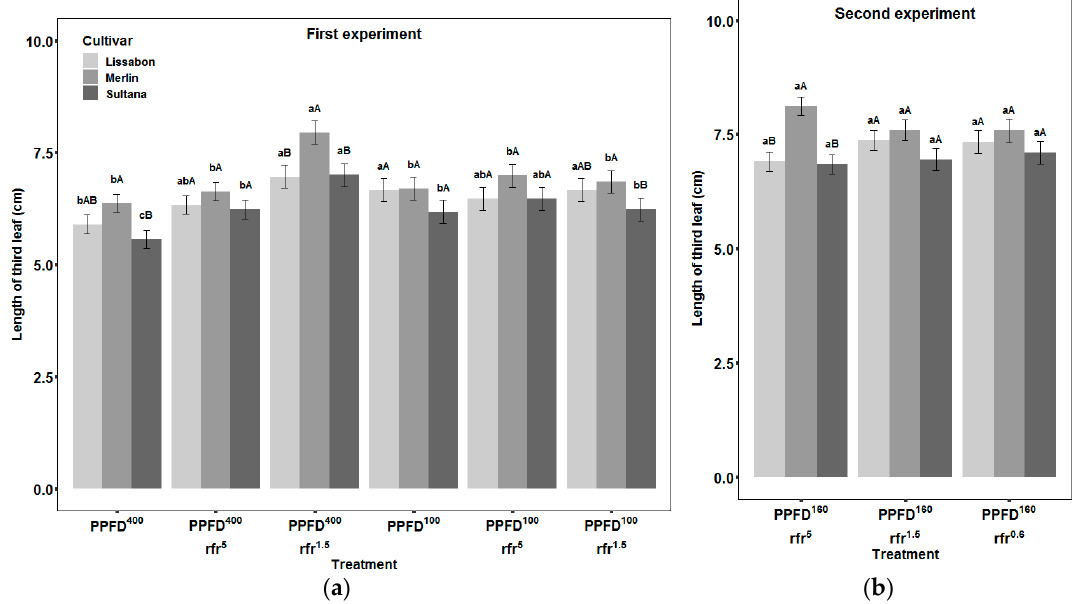
Figure 5. The least square means of leaf length of the third leaf for the three cultivars in the first ( a ) and second ( b ) experiment. Error bars indicate standard error of the LS-mean. For each experiment, lower case letters indicate significant differences between treatments for each cultivar, and upper case letters indicate significant differences between cultivars for each treatment ( p < 0.05).